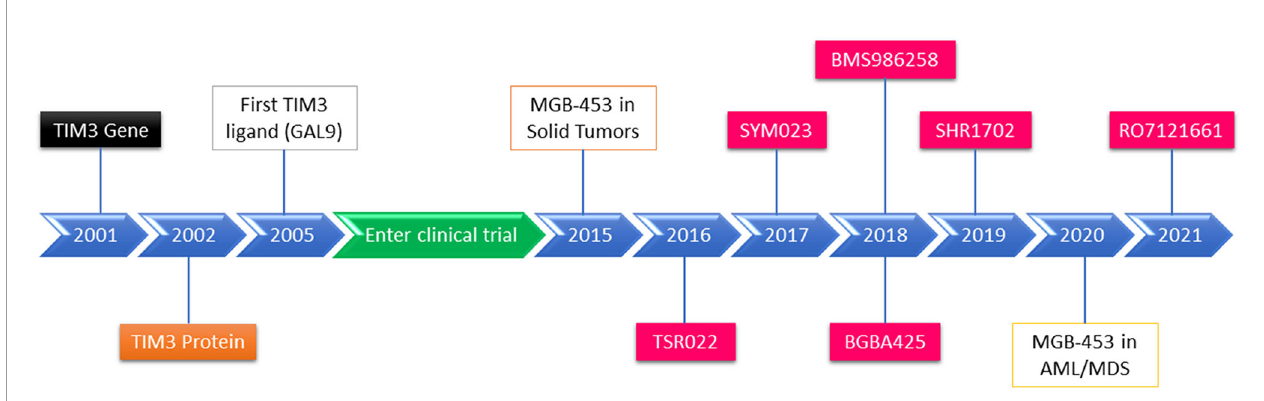
FIGURE 2 | Schematic diagram of TIM-3 identi fi cation, TIM-3 inhibitor development, and TIM-3 blockade in cancer and leukemia therapies in clinical